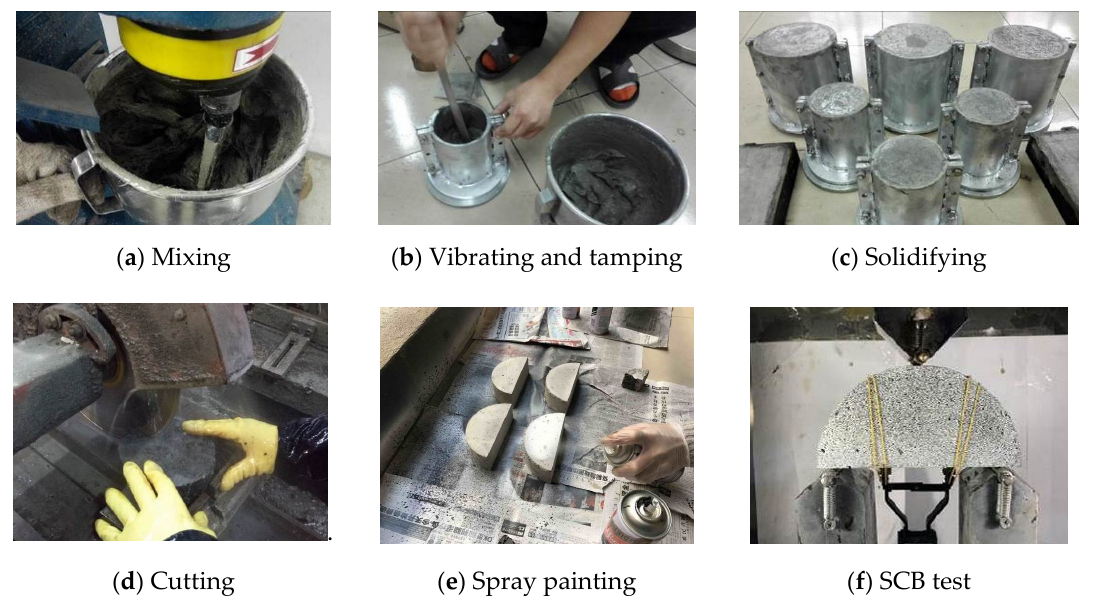
Figure 3. ECC semi-circular bending (SCB) specimen preparation process.